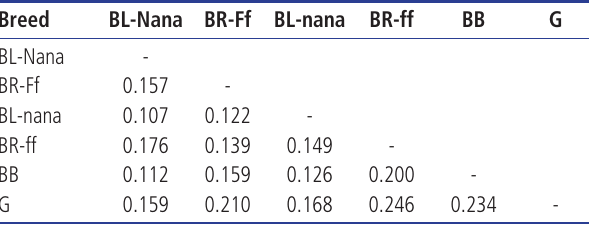
Table 6. Genetic distance matrix among Saudi native chicken breeds